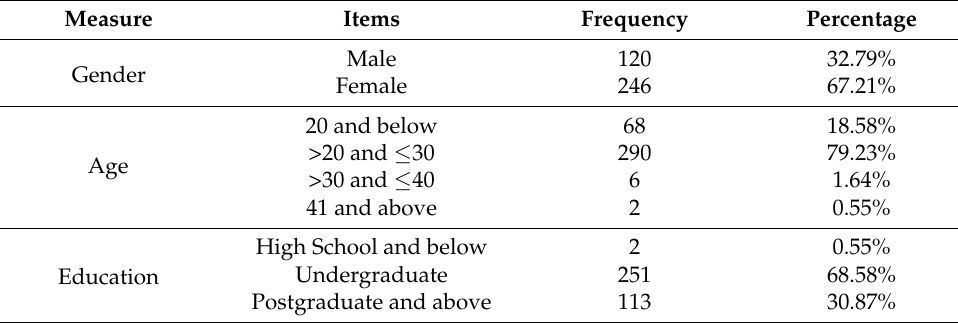
Table 3. Descriptive statistics.